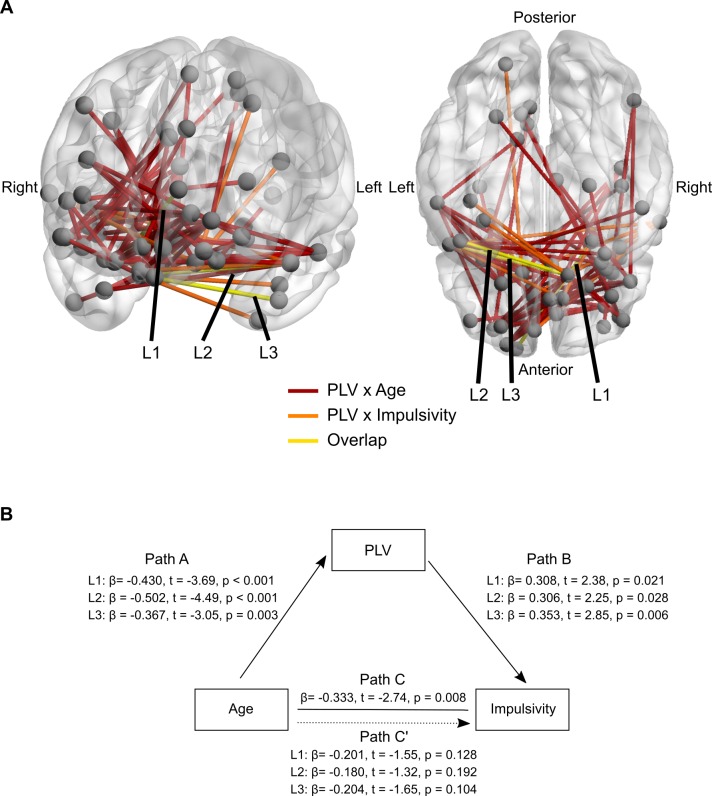
Frontolimbic 5–9 Hz phase-locking is related to decreased impulsivity during adolescence.(A) Anatomical location PLV × Age and PLV × Impulsivity relationships. Red links denote the significant PLV × Age NBS cluster. Orange links denote the significant PLV × Impulsivity NBS cluster. Yellow links denote overlap between the 2 clusters. These overlapping links were tested for mediation. (B) Mediation model including statistics for specific paths. Note PLV of these 3 interactions fully mediated the relationship between age and impulsivity (difference in p-values between path C and paths in C’), confirming overlap of clusters. NBS, network-based statistic; PLV, phase-locking value.